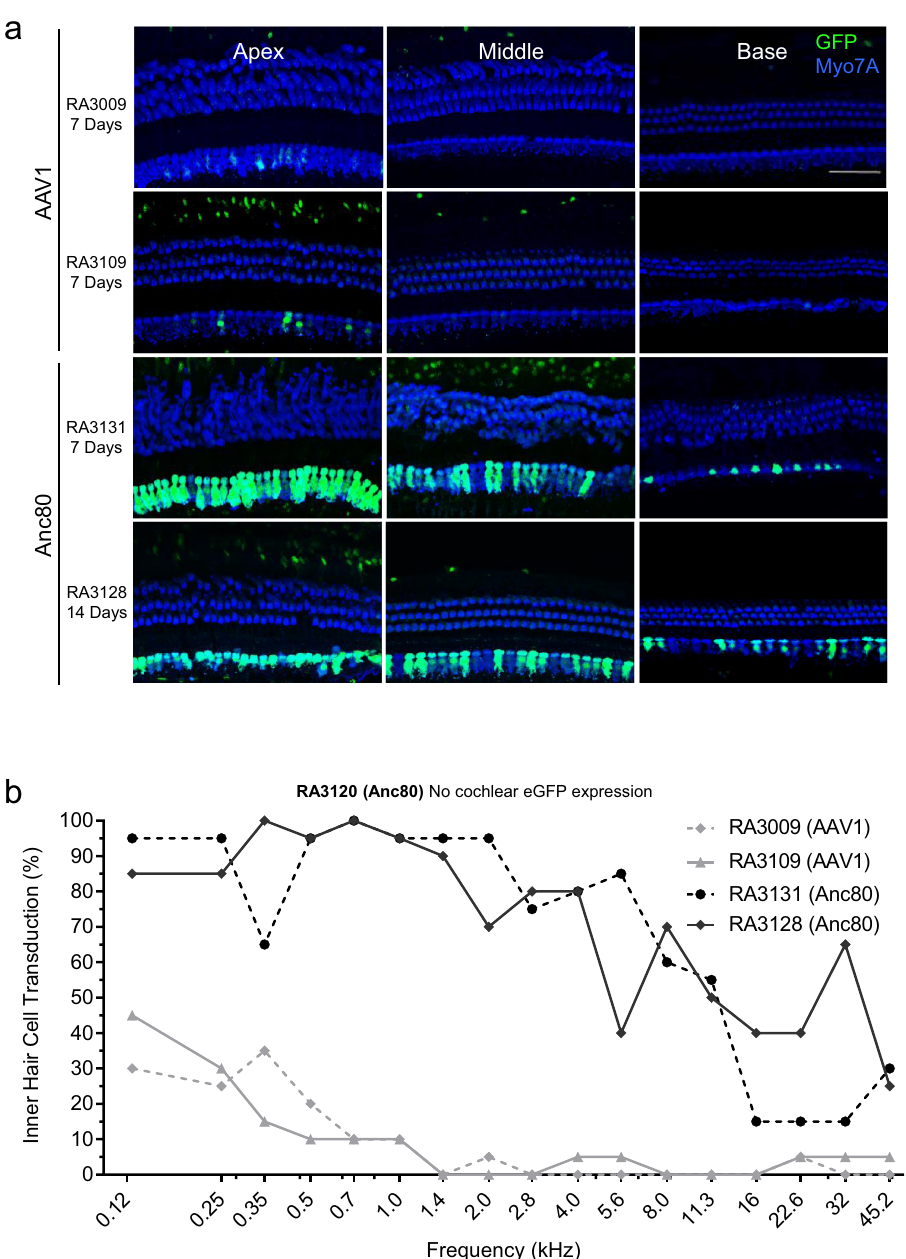
Fig. 3 In vivo transduction of cochlear cells with AAV1 and Anc80L65 in rhesus macaques. a Confocal representative images ( n = 2 for AAV1 and n = 2 for Anc80L65) of whole mounts of the organ of Corti areas along the length of the cochlea for all injected inner ears that expressed eGFP (green). Animals were injected with 30 µ l of viral vector, total dose of 2.55 × 10 11 GC. Blue, Myo7A-stained hair cells. Scale bar, 50 µ m. No expression in any cell type was detected in RA3120 (Anc80). b Quanti fi cation of inner hair cell transduction following round window membrane (RWM) injection. Percentage of eGFP- positive inner hair cells (IHCs) per frequency region along the length of the cochlea. Identical confocal microscope settings were used to obtain all images. Source data are provided as a Source Data fi